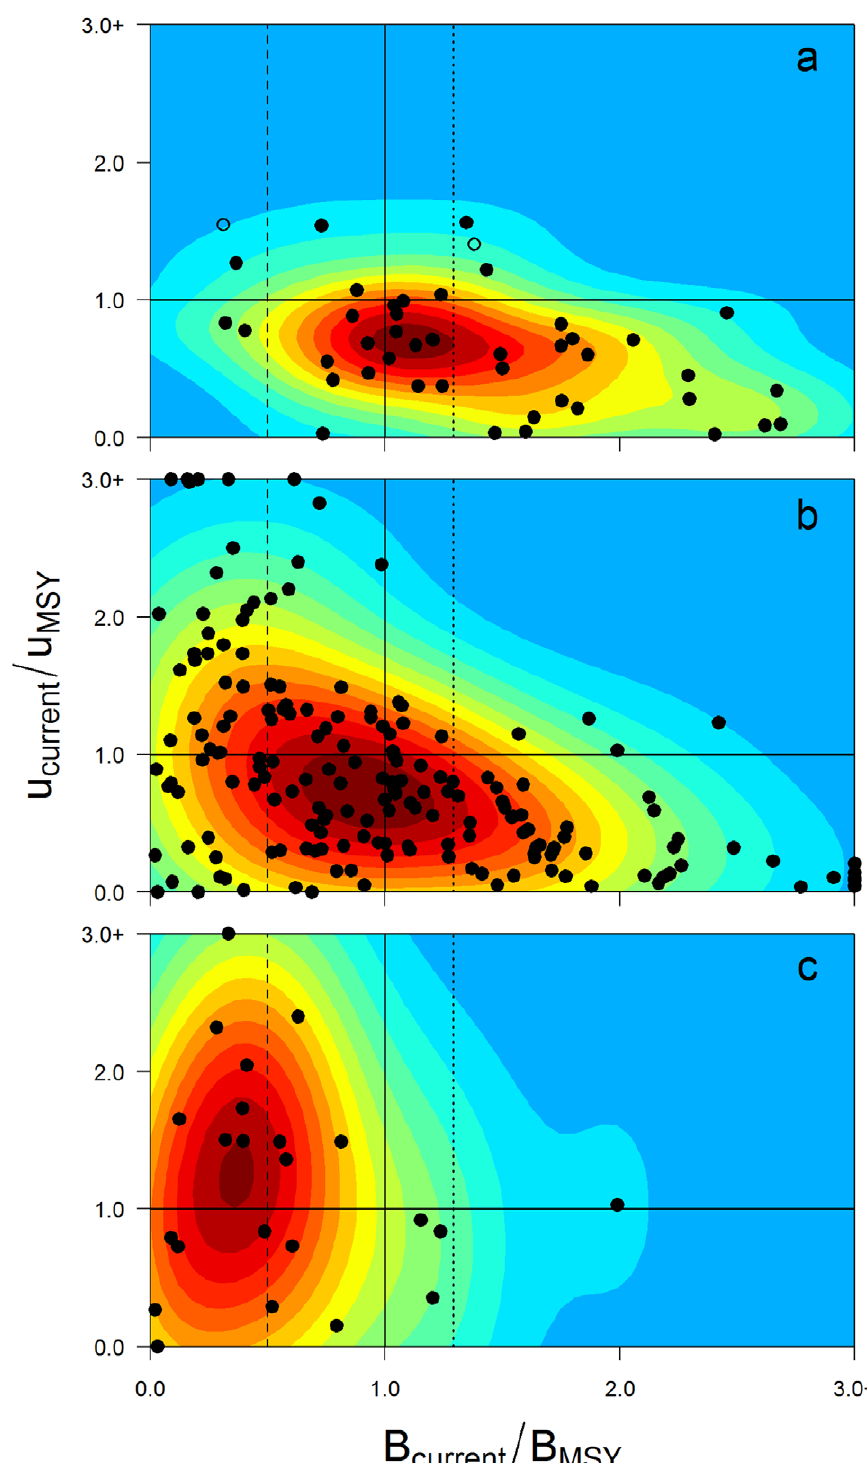
Figure 1. Sustainability of certified and uncertified seafood. Current (i.e., most recent year with available information) biomass and exploitation rate for ( A ) individual certified ( n =45); ( B ) all uncertified ( n =179); and ( C ) uncertified stocks that went through pre-assessment and were not recommended for certification ( n =25). Data are scaled relative to B MSY and u MSY or F MSY (the biomass and exploitation rates or fishing mortality rates that produce maximum sustainable yield). Contour colors show probability of occurrence (red indicates the highest probability and blue the lowest). Vertical and horizontal solid lines represent reference points common to all fisheries ( B/B MSY=1 and u/u MSY or F/F MSY=1). Dotted lined represents B =1.3 B MSY and dashed line B =0.5 B MSY. Footnote: New assessments for some fish stocks were released while this paper was in press, but this figure was not updated to maintain consistency in year of release.